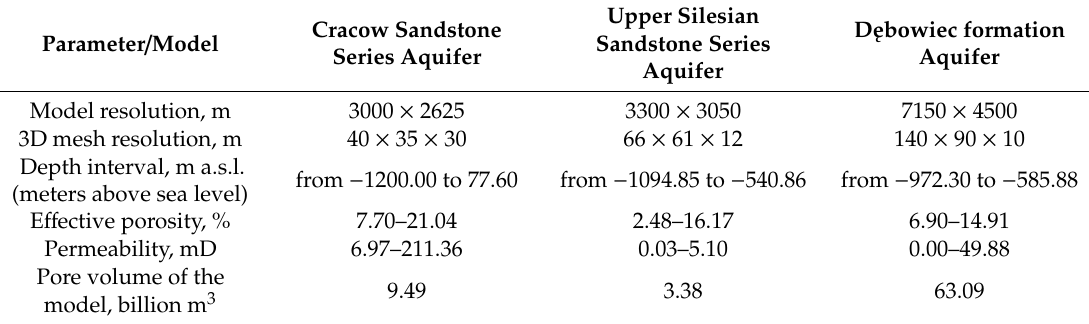
Table 1. Details of the reservoir simulation model.